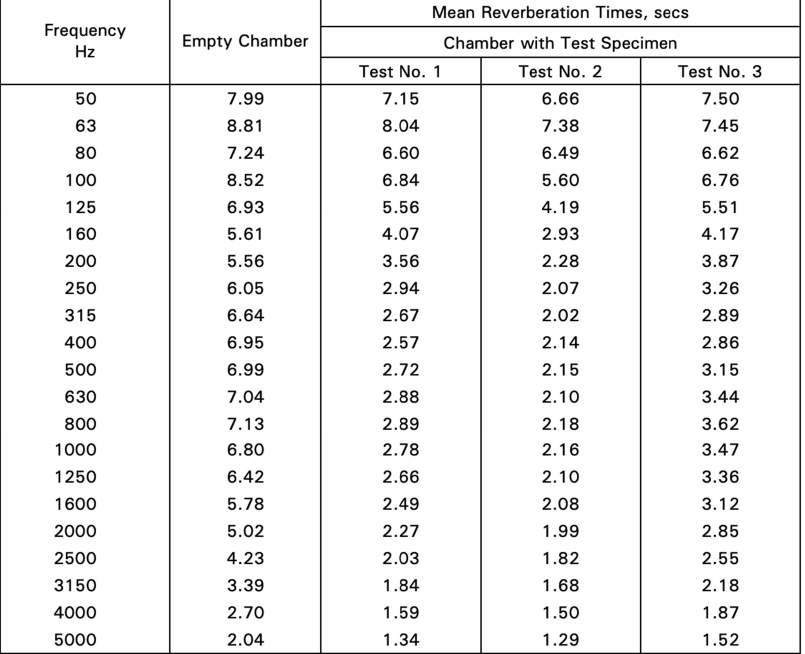
Figure 6. Mean reverberation times: (Test No.1) Biotecture living wall system with fully planted panels; (Test No.2) Biotecture living wall system with dry panels; (Test No.3) Biotecture living wall system with wet un-planted panels.